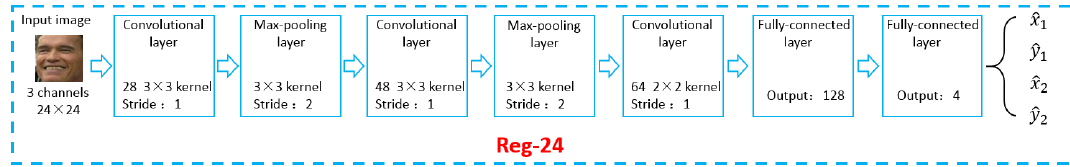
Figure 8. The CNN structure of